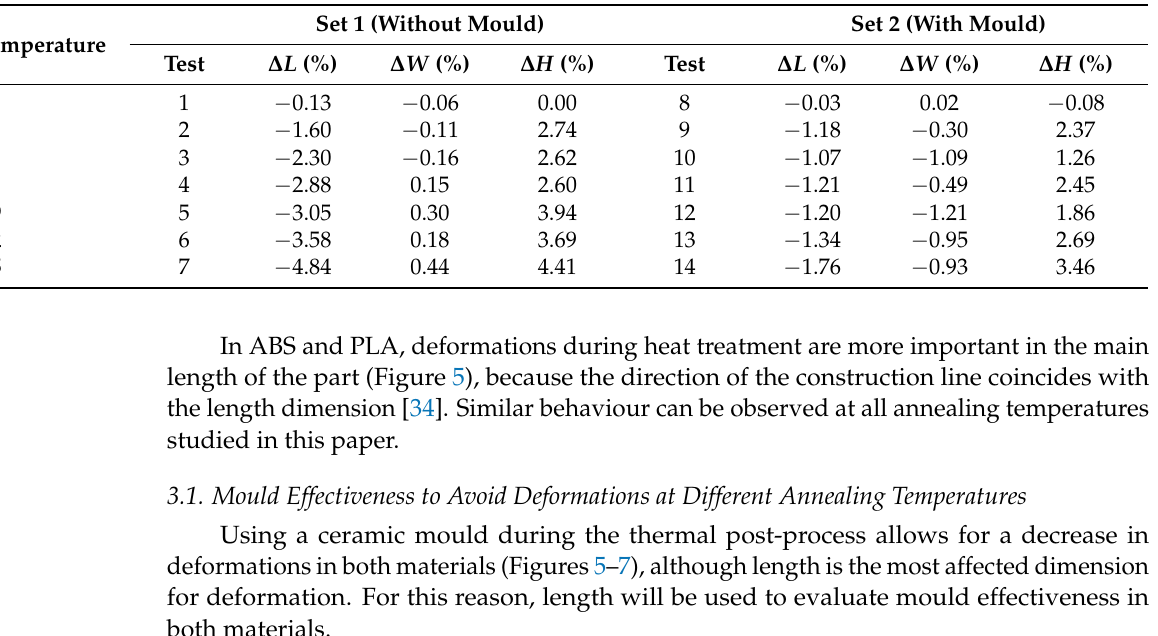
Table 5. PLA average dimensional changes after thermal